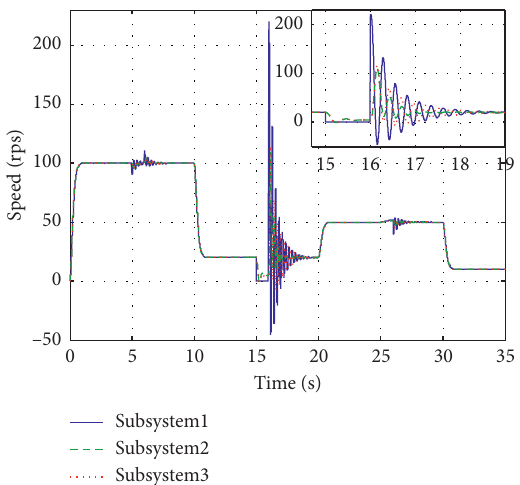
Figure 5: Tolerance synchronous output after the fault.